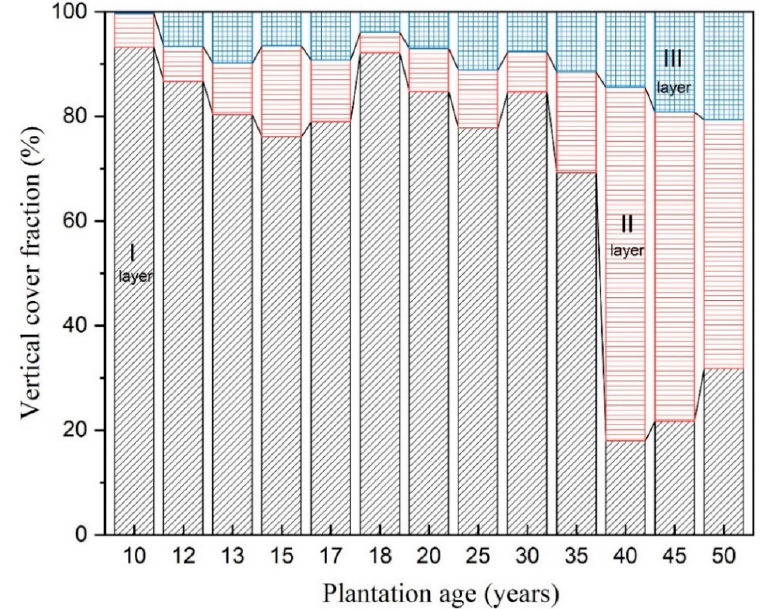
Figure 3. Mean vertical cover fractions (%) of understory species for chronosequence of Robinia pseudoacacia plantations.